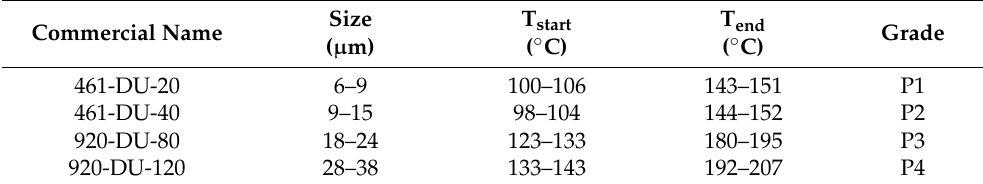
Table 1. Thermally expandable polymer microspheres